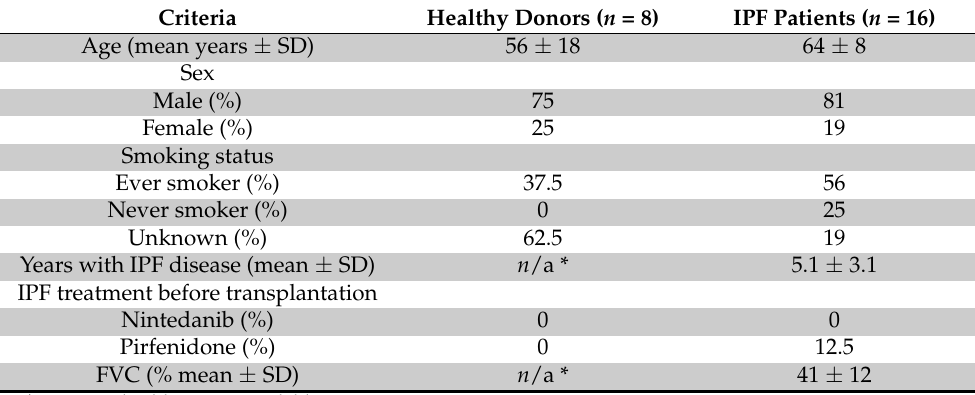
Table 1. Participant demographics.